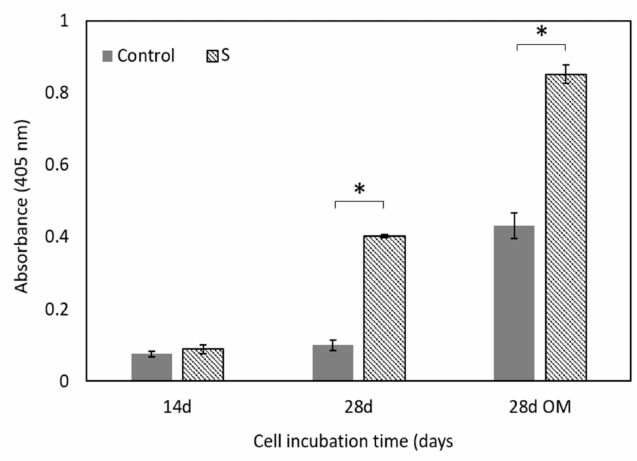
Figure 9. The quantification of ALP activity of the ah-MSCs seeded on scaffold surfaces (S) and the positive control (Control) after different culture times in GM and OM. * denotes significant differences ( p < 0.05) between them at the same culture